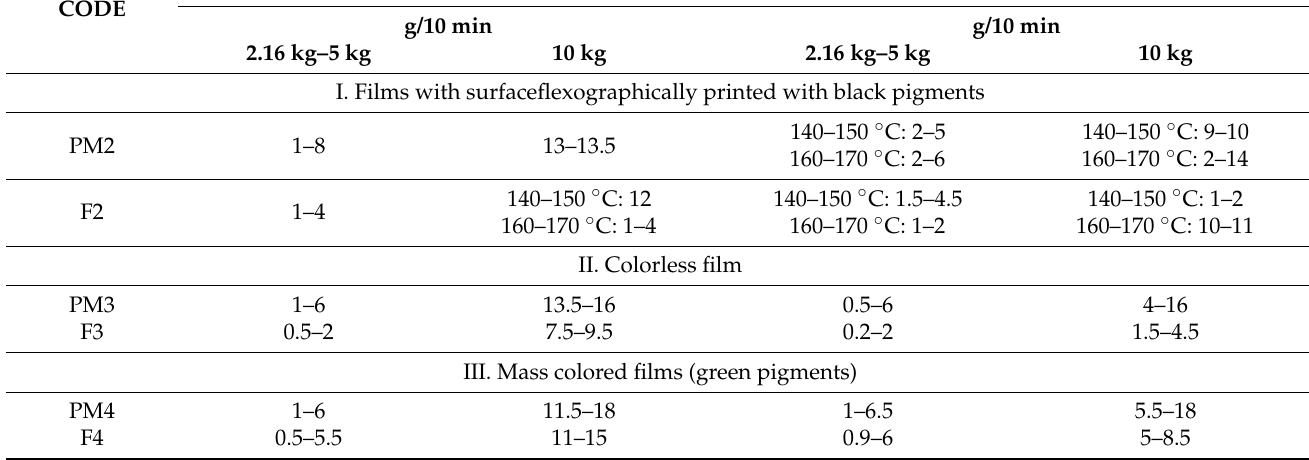
Table 3. The variation of the fluidity increment in the ranges of 130 ◦ C–170 ◦ C and 2.16–10 kg load for mechanically recycled pre-consumer wastes and primary